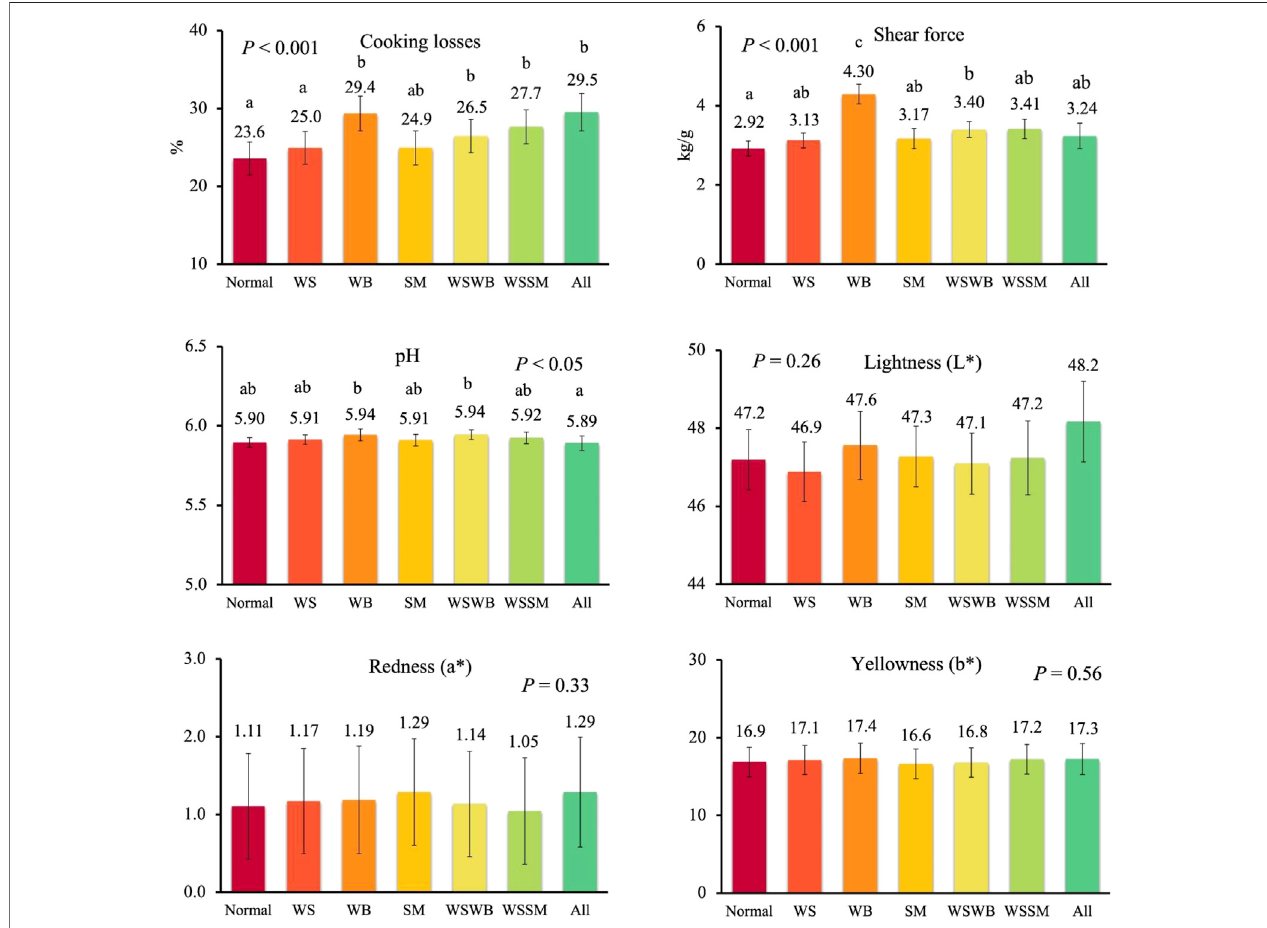
FIGURE 4 | Meat quality in normal breasts and in breasts affected by exclusively white striping (WS) or wooden breast (WB) or spaghetti meat (SM), or contemporarily all myopathies (All), or WS and SM, or WS and WB. Data are presented as LS means ± standard error. Different letters above bars indicate signi fi cant differences between LS means [Number of chickens per group available in Supplementary Table S2 ].